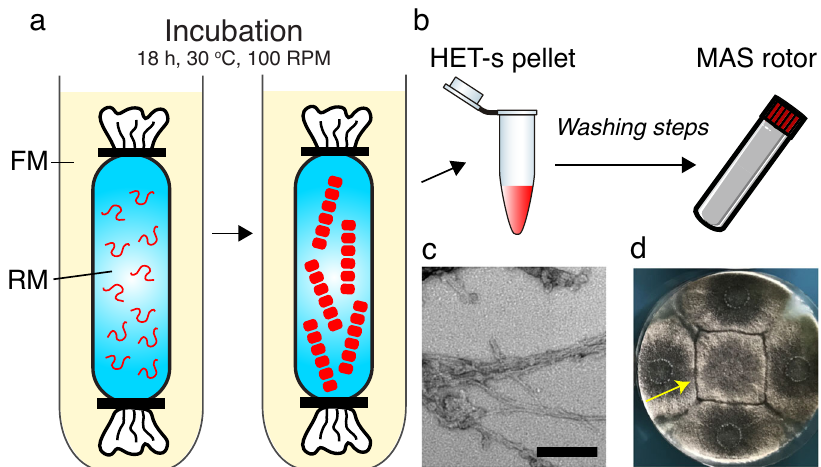
Fig. 1 Cell-free synthesis of amyloid proteins, illustrated with the prion-forming domain of HET-s. a Schematic representation of the production of cell- free synthesized HET-s amyloid fi brils. RM: reaction mixture. FM: Feeding mixture. b RM is harvested using centrifugation and washed to obtain the NMR sample. c Electron micrograph of CF synthesized HET-s PFD amyloid fi brils. Scale bar: 100 nm. d CF-synthesized HET-s PFD triggers the phenotypic conversion of [Het-s*] strains (infection) detected as a regulated cell death reaction as observed by the barrage reaction (yellow arrow) when the focal strain in the center of the plate is confronted to the four [Het-S] strains at the